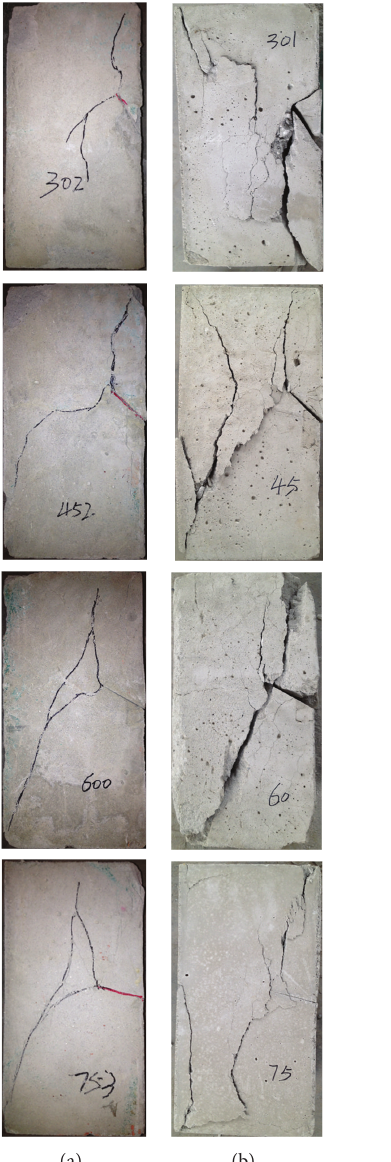
Figure 9: Failure of fissured rocks. True triaxial unloading test (a) and uniaxial compression test (b).